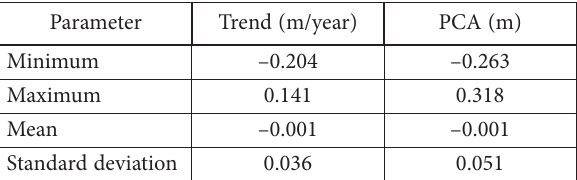
number and cluster 3 having the lowest number. Figure 2d shows percentage of each cluster that the first cluster has the highest percentage. Table 1 shows the statistical characteristics of the results. Table 1. Statistical characteristics of the